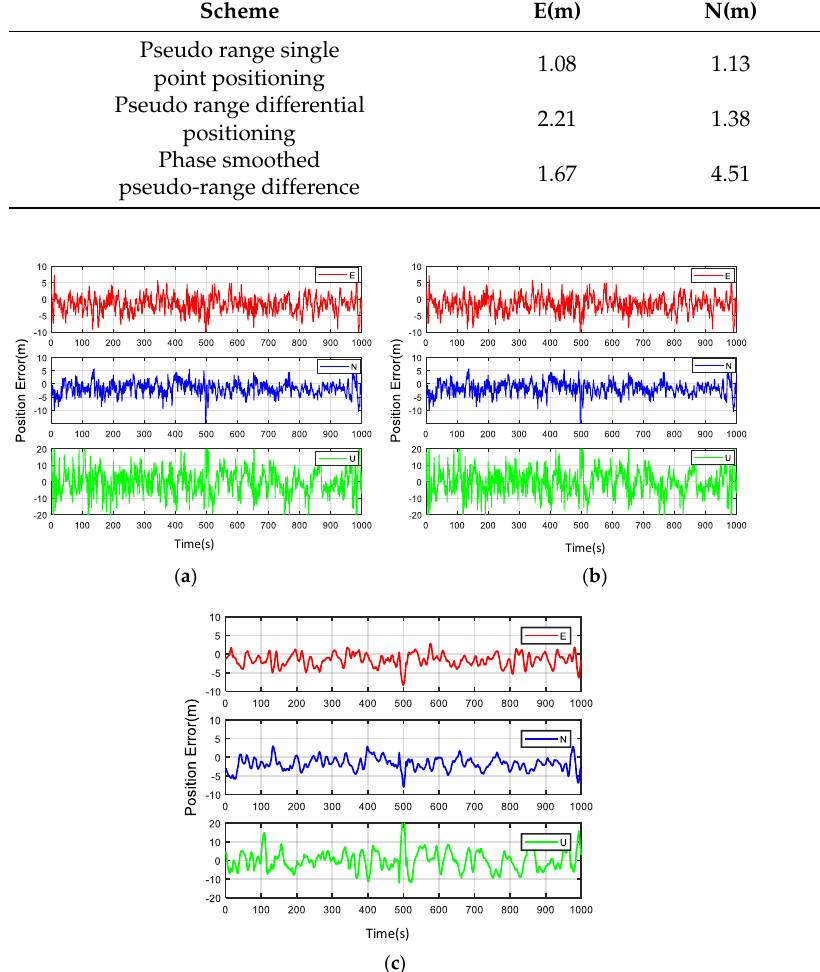
Table 2. Statistics of GNSS positioning error.